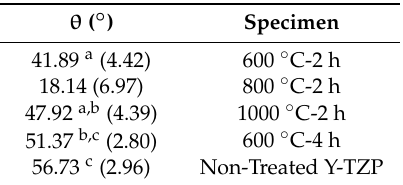
Table 3. Contact angles against double-distilled